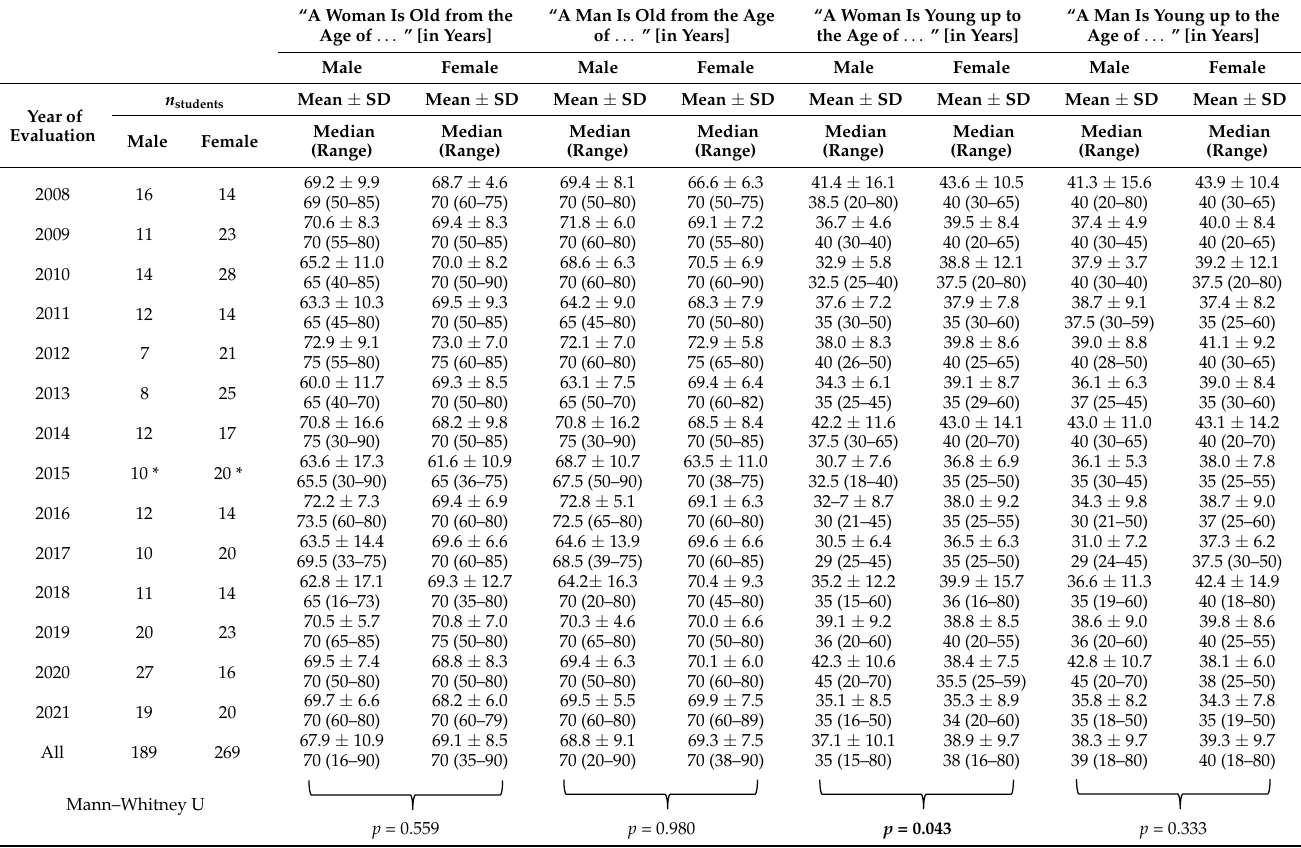
Table 2. Student definitions of “young” and “old” by year (2008–2021) and by gender. (different n per gender and question: * n = 22 for female students and question “A woman is young up to the age of . . . ”; n = 12 for male students and question “A woman is old from the age of . . . ”) (bold values indicate p ≤ 0.05) (based on data from (23) and